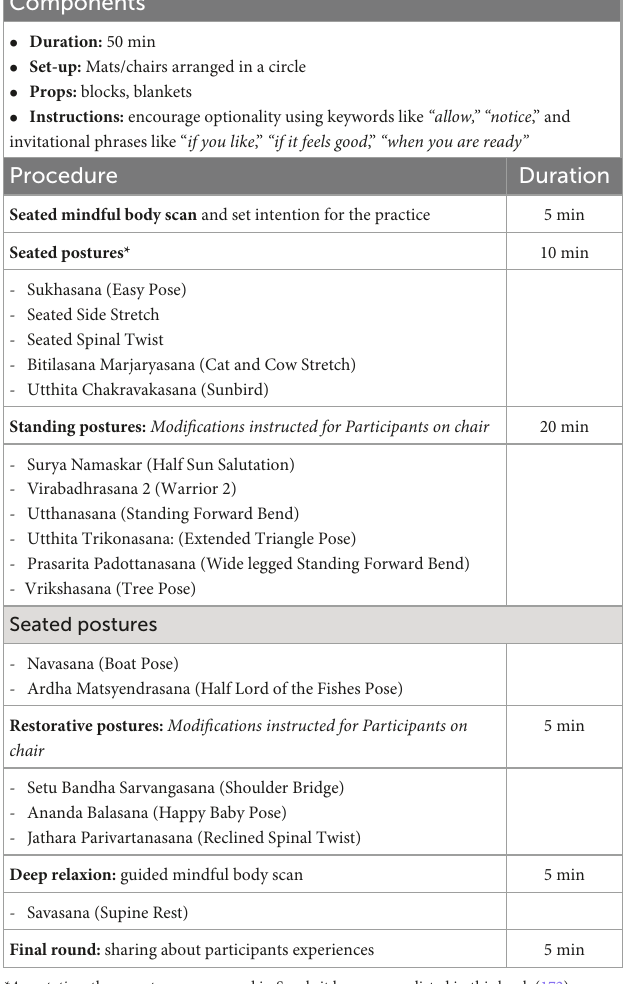
TABLE 3 Procedure of yoga-based group intervention (YoGI).